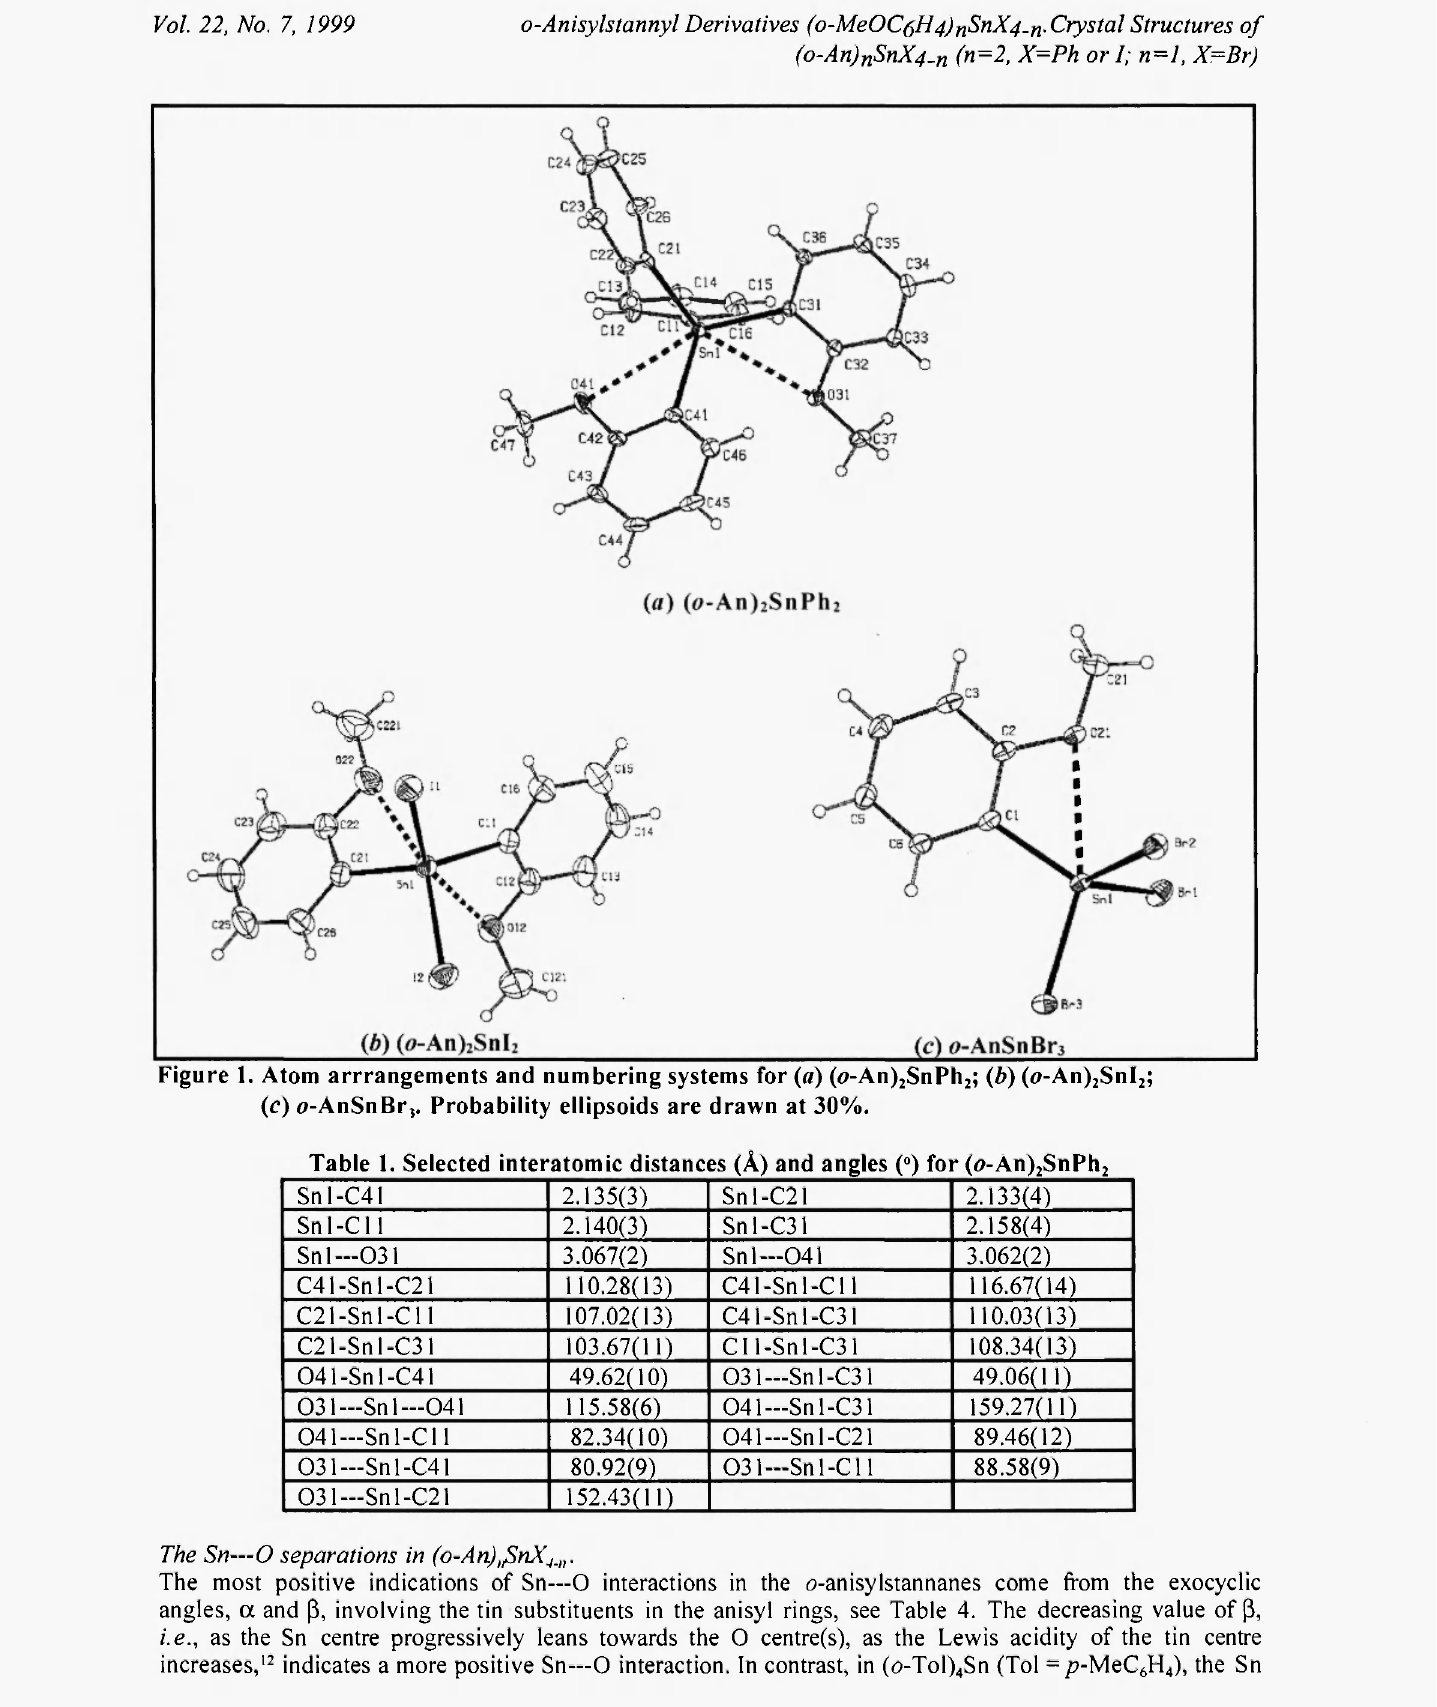
Figure 1. Atom arrrangements and numbering systems for («) (o-An) 2 SnPh 2 ; (ft) (o-An) 2 SnI 2 ; (c) o-AnSnBr,. Probability ellipsoids are drawn at 30%. Table 1. Selected interatomic distances (Ä) and angles (°) for (o-An) 2 SnPh